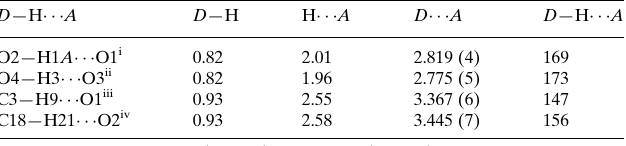
Hydrogen-bond geometry (A˚ , (cid:2)